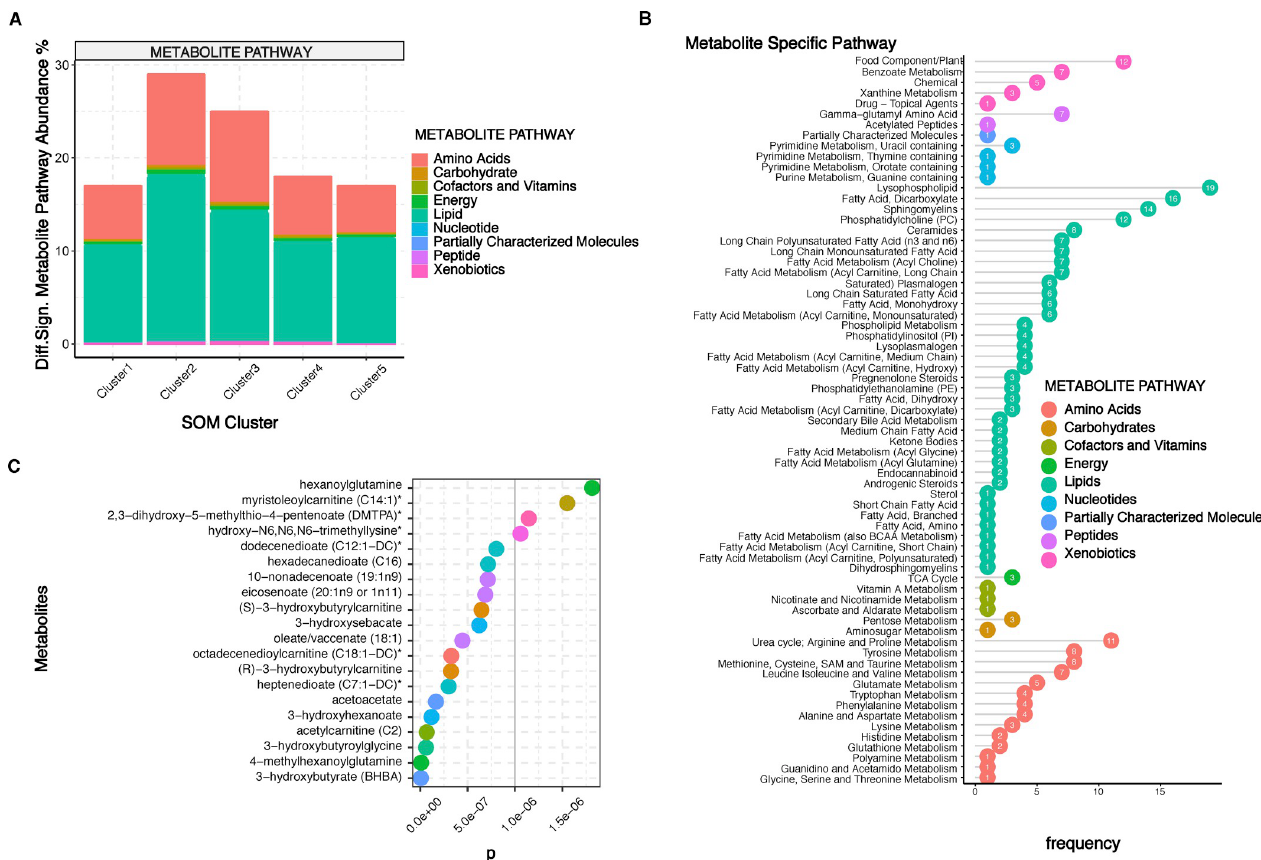
Fig 2. Differentially abundant metabolites and metabolic pathways among the five defined SOM clusters (metabotypes). (A ) Relative abundance and distribution of differentially significant metabolites among SOM and k-means defined clusters. Clusters two and three are most abundant in lipids (especially lysophospholipids and sphingomyelins) and amino acids (urea, arginine and proline metabolism). (B) Distribution of differentially significant metabolic pathways among SOM and k-means defined clusters, where numbers within each dot indicate how many metabolites of that particular specific pathway were differentially abundant across clusters. (C) Top 20 differentially significant metabolites among the SOM and k-means defined clusters, ( P < 0 . 05